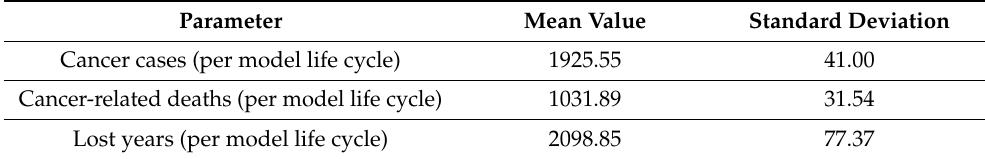
Table 2. Hypothetical scenario modeling